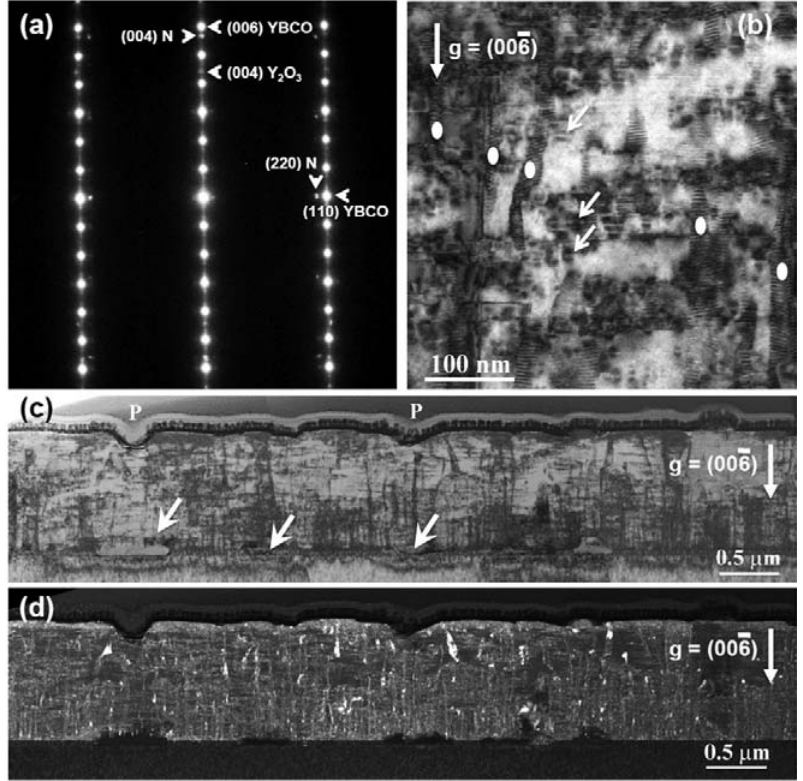
Figure 5. ( a ) TEM diffraction data for the 0.9 µm thick film showing the alignment of the Ba YRuO phase with YBCO; ( b ) High magnification bright field TEM image showing the 2 6 BRYO nanords (white dots) and strained and tilted Y magnification TEM bright field ( c ) and weak-beam ( d ) images showing a mostly uniform distribution of secondary phases in this particular TEM specimen.